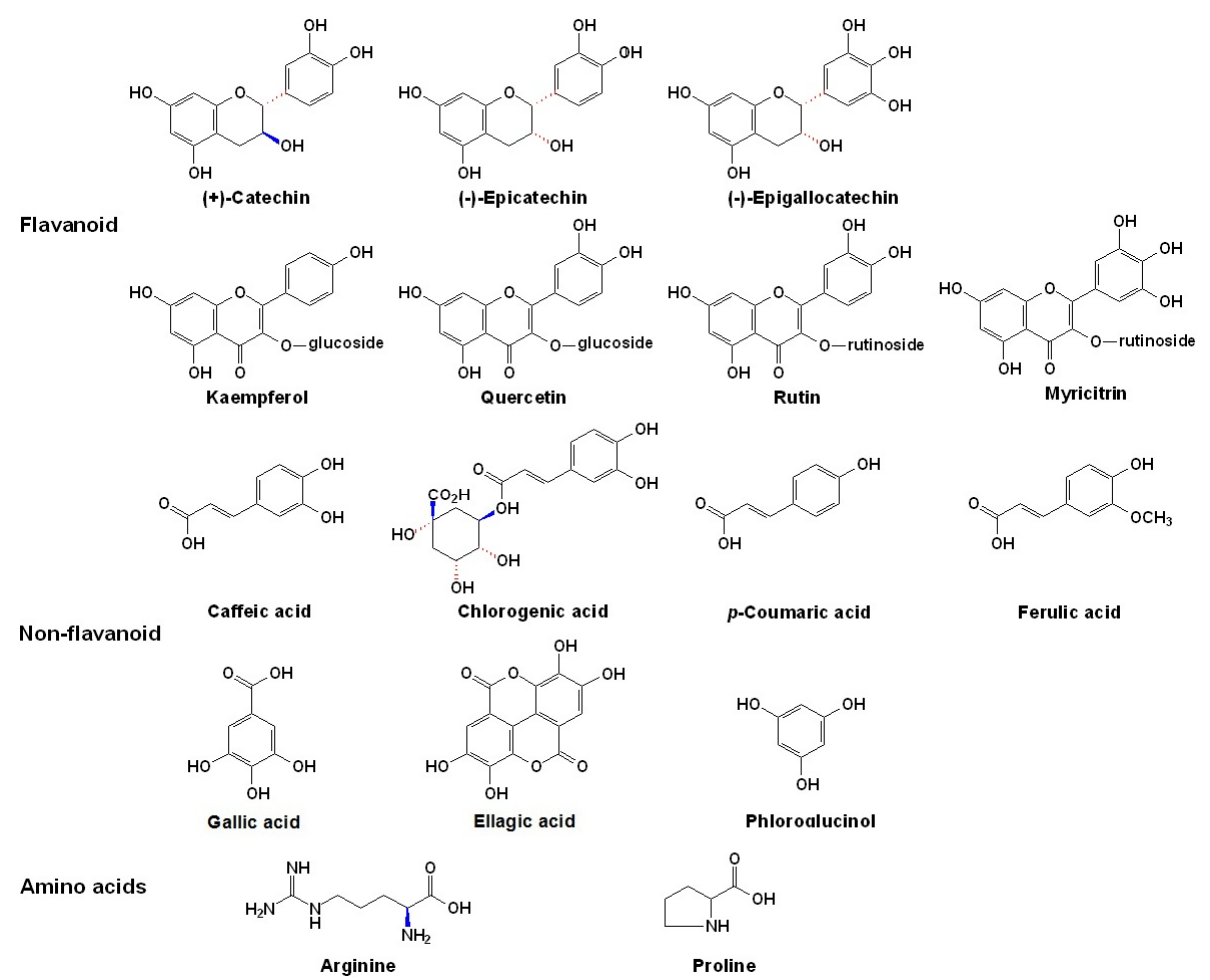
Figure 4. The structures of the major cofactors naturally occurring in young red wines